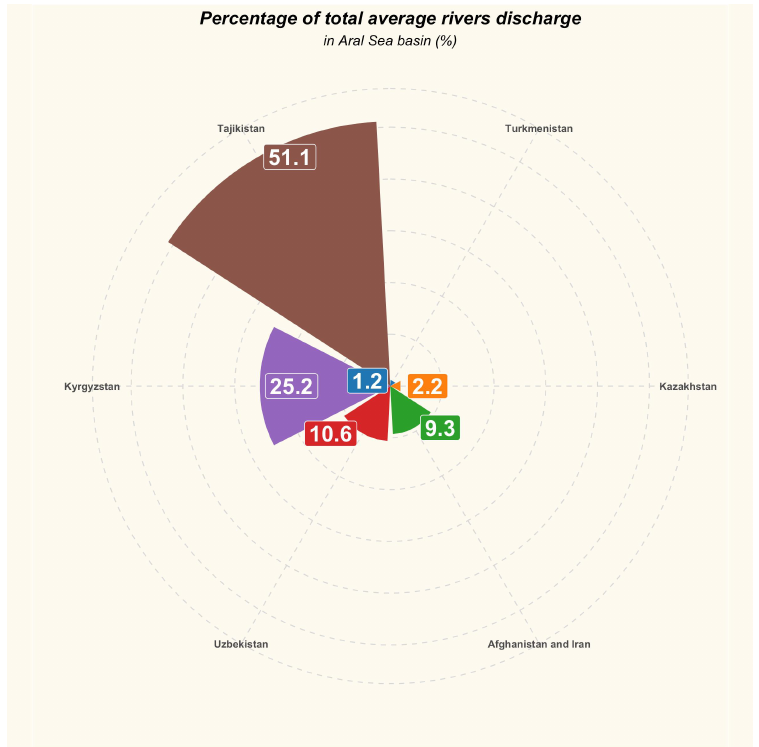
Figure 3. Percentage of average total rivers’ discharge in Aral Sea basin per country. Data source: Investicii v vodno-jenergeticheskij kompleks Central’noj Azii, Evrazijskij Bank Razvitija, Almaty 2021, p.